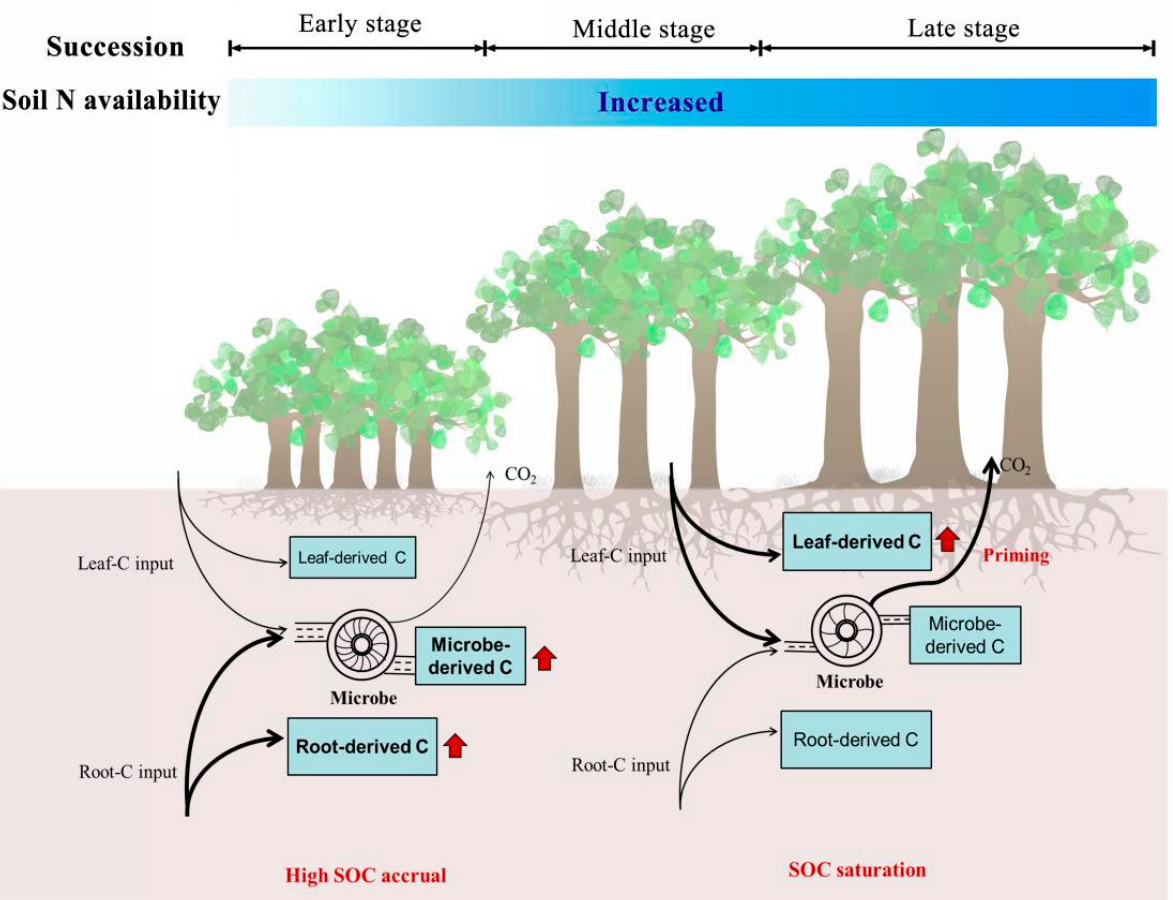
Figure 7. Improved conceptual framework explaining the process of SOC accrual in subtropical successional forests. The thickness of black arrows represents the size of soil C flux. Red arrows indicate the increasing C pool. The number of blades in the pump is positively correlated with microbial C turnover.